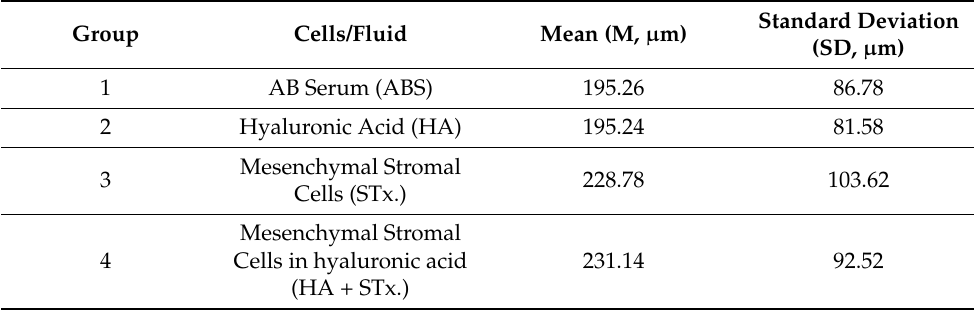
Table 1. Overview of group-specific cartilage thickness measurements (across all measurement points), showing mean values and standard